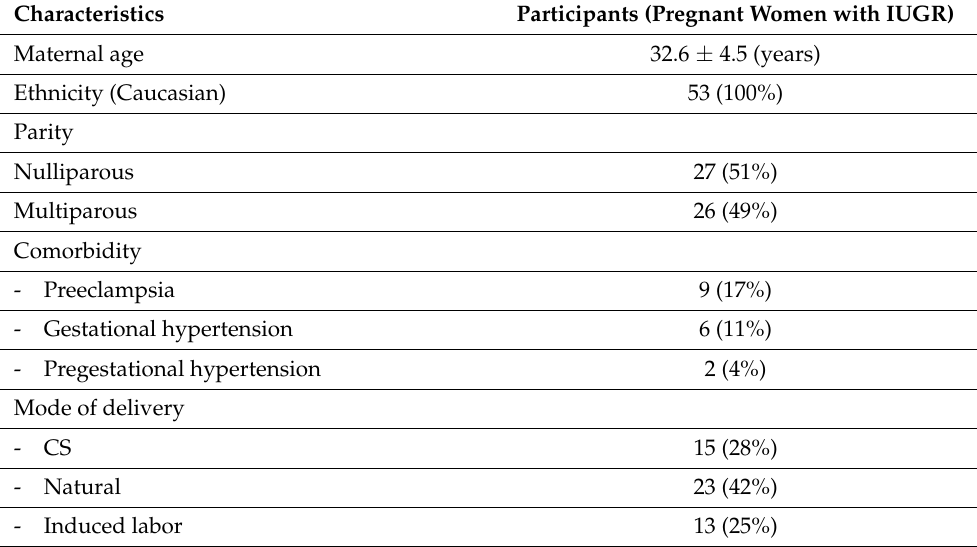
Table 1. Subject characteristics in pregnant women with IUGR.